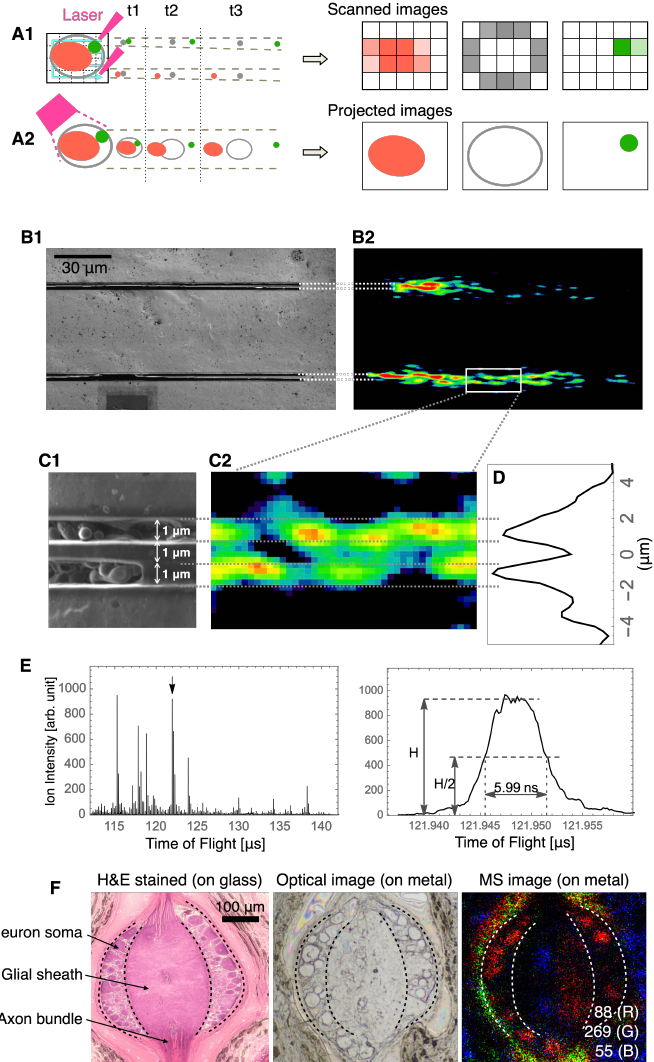
Figure 2. Ion flight mode and spatial/mass resolution in STCM IMS. ( A ) Schematic diagrams for the flight mode of ions in STCM IMS and the conventional scanning-type IMS. ( A1 ) depicts the ion flight mode for conventional scanning-type IMS and ( A2 ) depicts the ion flight mode for STCM IMS. Red, green, and gray spots indicate the distribution patterns of three ionized molecules that possess different masses. Distances among different color spots in t1, t2, and t3 indicate differences in flight times based on the unique mass value assigned in each ionized molecule. On the right, three images created by the conventional scanning-type IMS ( upper three ) and by STCM IMS ( lower three ) are shown. ( B ) Electron microscope images of physicochemical test lines for spatial resolution. Two 1 µm wide metal slits, each painted with crystal violet, were placed 1 µm apart ( B1 ). Ions extracted from crystal violet were visualized as two separate lines ( B2 ). ( C ) Enlarged view of the test lines ( C1 ) and magnified MS signals ( C2 ) taken from the portion enclosed by the yellow box in B2. ( D ) Two peaks in the intensity curve quantitatively confirm the graphical presentation of MS signals in ( C2 ). ( E ) Evaluation of mass resolution using the peak identified as the crystal violet ion at 121.948 µs in the mass spectra. ( F ) The leech somatic ganglion sectioned at 8 µm thick and stained with hematoxylin and eosin ( left ). An unstained section of the ganglion with the same thickness ( middle ), mounted on a mirror-polished stainless-steel plate, is viewed by our special microscope shown in Figure 1A. Subcellular localization of three ionized molecules, m / z 88 (R), m / z 269 (G), m / z 55 (B), imaged in the same section are shown in the middle panel ( right ). Dashed lines in each panel indicate anatomical boundaries. A calibration bar on the left panel is 100 µm and is shared by all three